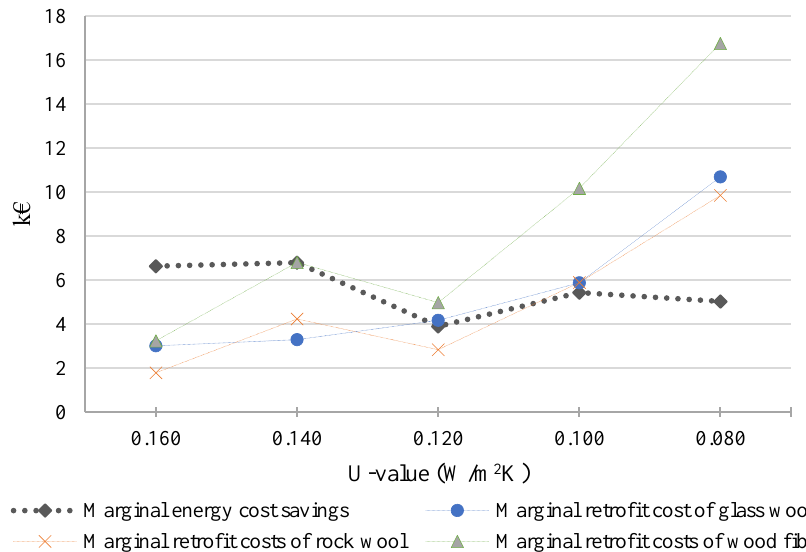
Figure 3. Marginal energy cost savings and marginal retrofit costs of extra insulation on attic floor using glass wool, rock wool, and wood fiber.